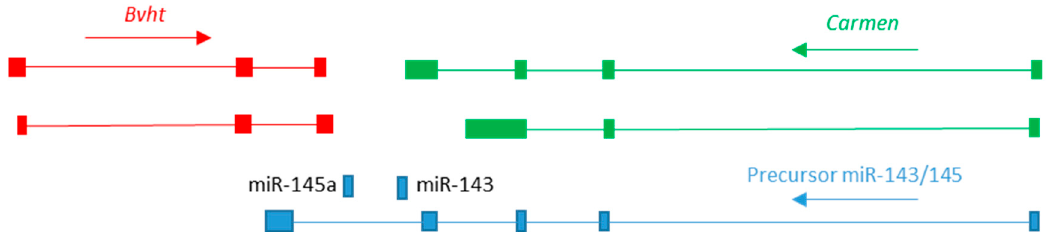
Figure 1. Organisation of the mouse Braveheart/Carmen locus. Cartoon to illustrate the genomic organization. Each long non-coding RNA (lncRNA) is shown in a different colour and arrows indicate direction of transcription.